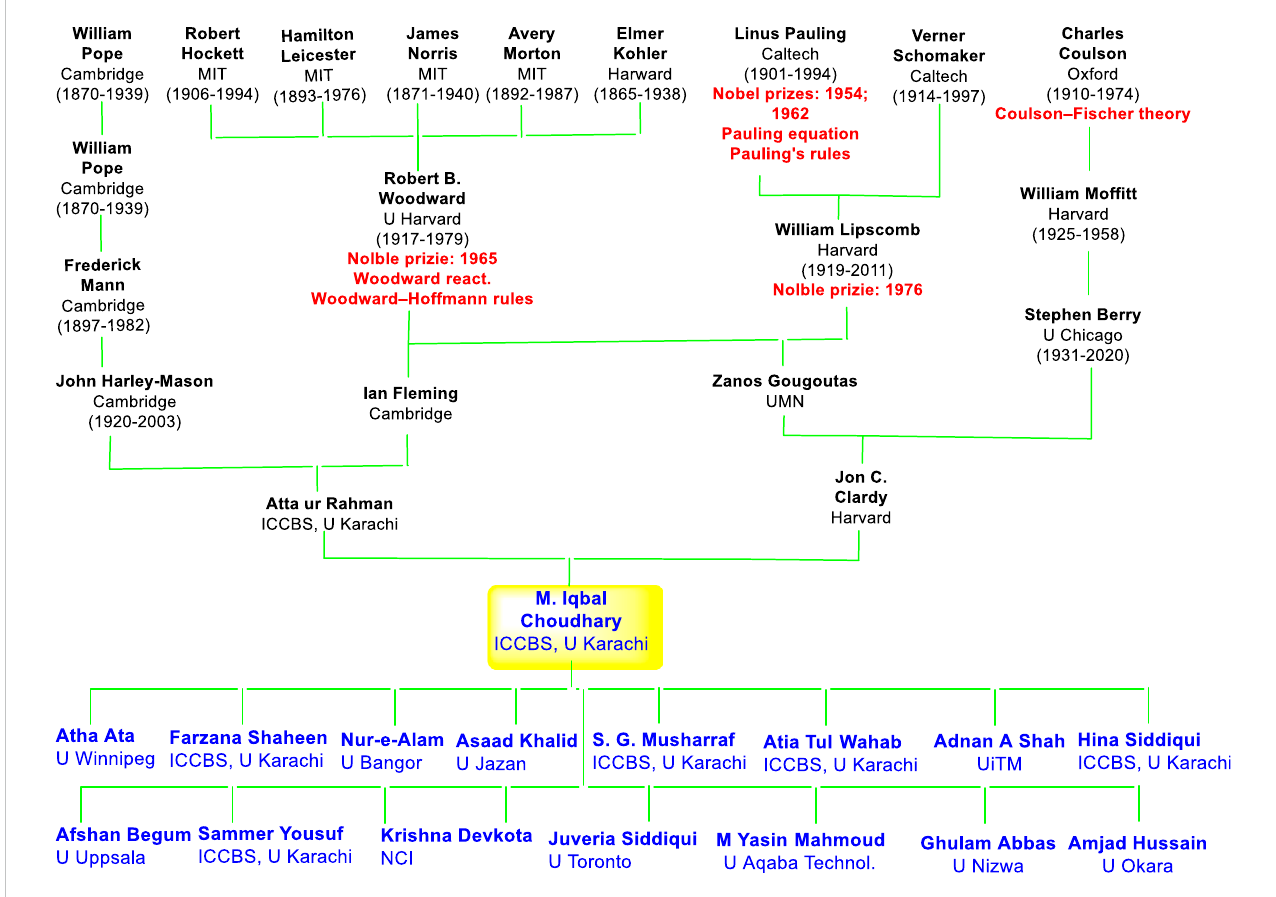
FIGURE 1 Muhammad Iqbal Choudhary ’ s academic family tree; only some of the Ph.D. students he has supervised and who eventually became university professors or researcher are included; all researchers including Ph.D. students) associated with him would exceed the limits of this